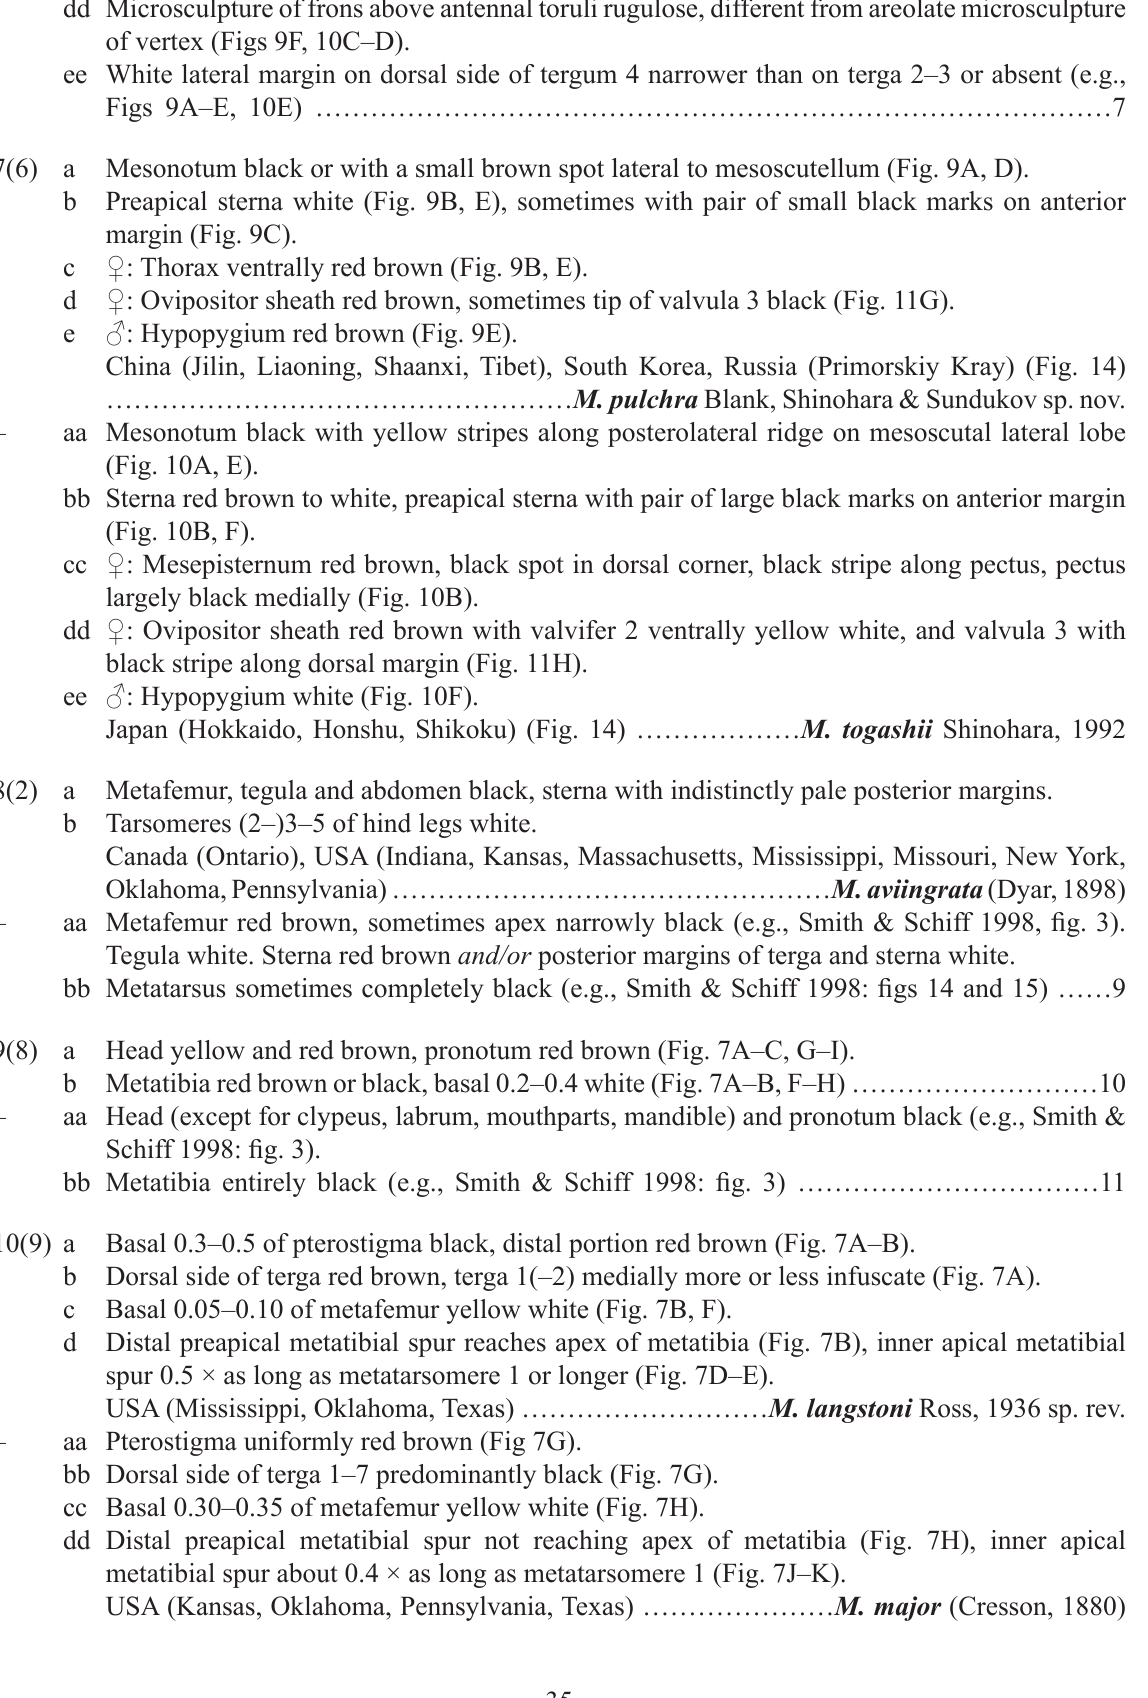
Microsculpture of frons above antennal toruli rugulose, different from areolate microsculpture of vertex (Figs 9F, 10C–D). White lateral margin on dorsal side of tergum 4 narrower than on terga 2–3 or absent (e.g., Mesonotum black or with a small brown spot lateral to mesoscutellum (Fig. 9A, D). Preapical sterna white (Fig. 9B, E), sometimes with pair of small black marks on anterior margin (Fig. 9C).